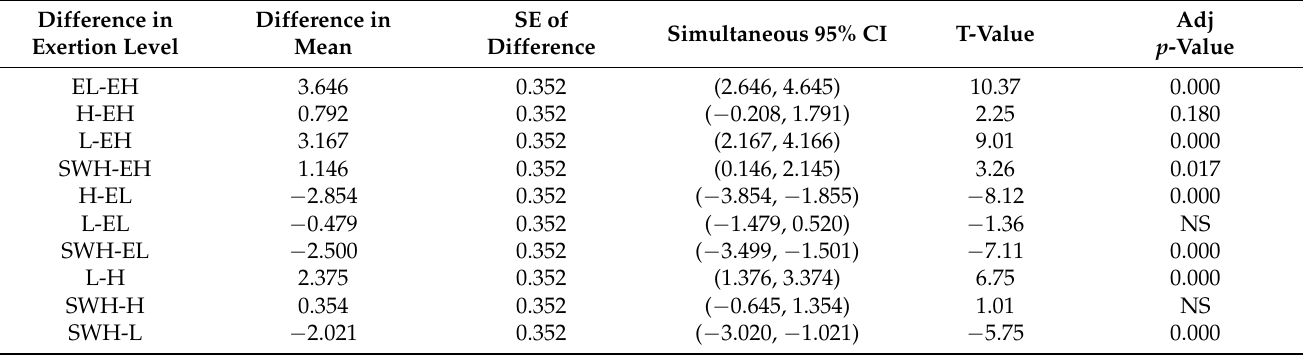
Table 9. Results of Tukey’s simultaneous tests for differences in the rate of perceived physical comfort scores at various levels of physical exertion. NS: not significant.